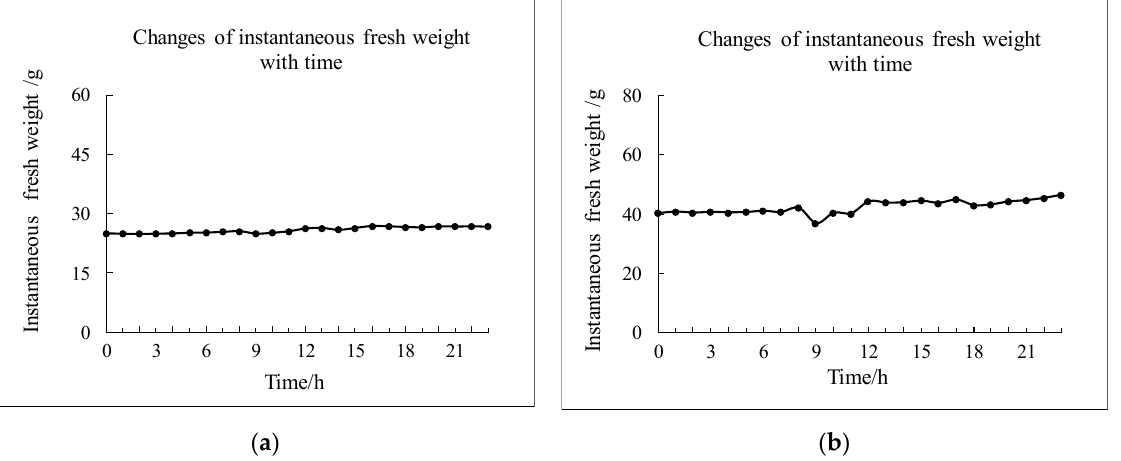
Figure 5. Fresh weight growth curves in different weather conditions. ( a ) On a cloudy day, ( b ) on a sunny day.